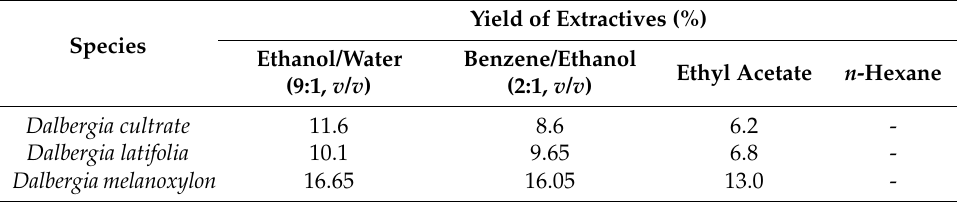
Table 1. Comparison of extractive contents in different solvents. Yield of Extractives Species